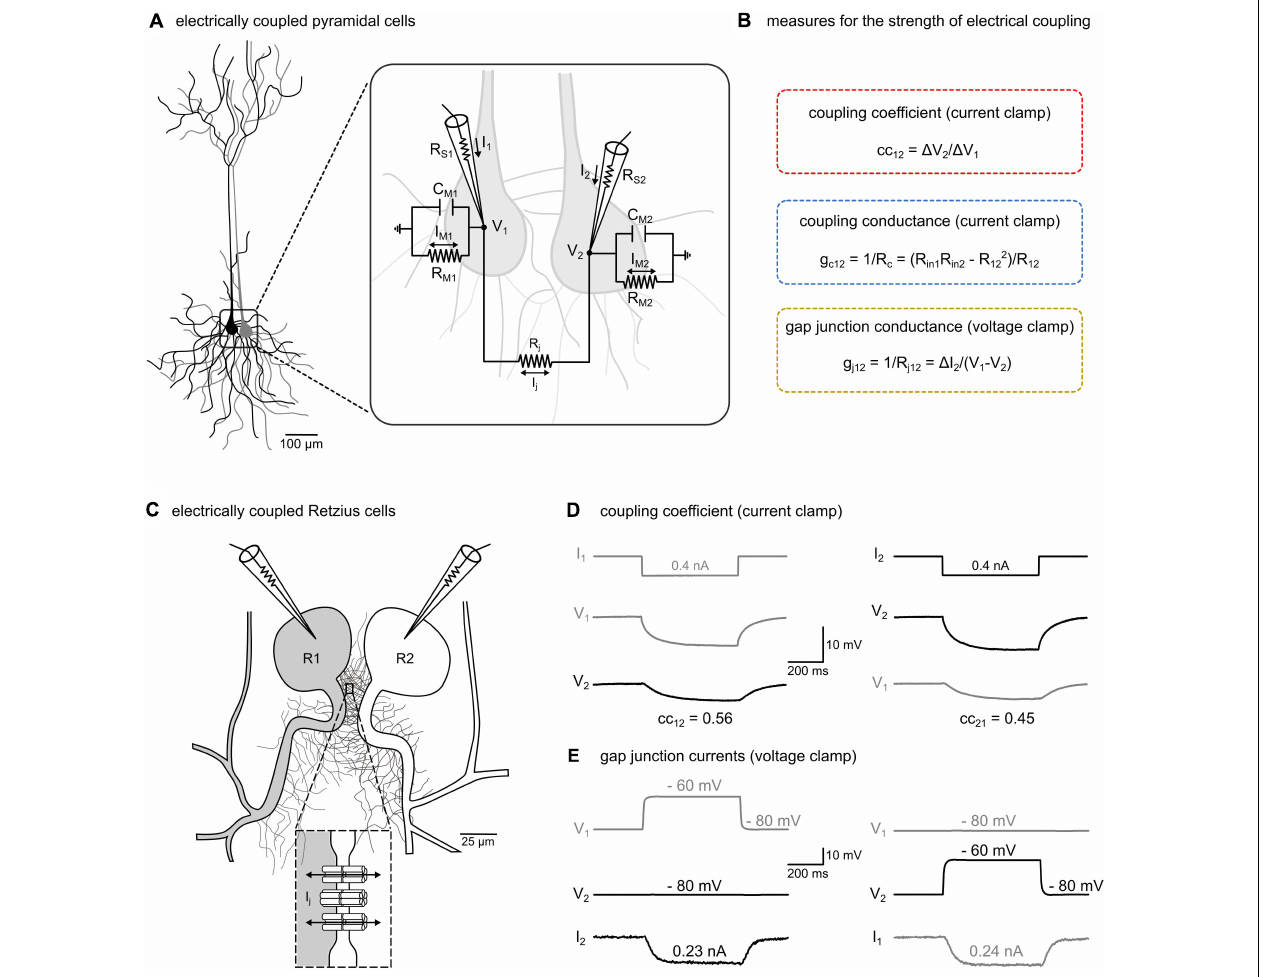
FIGURE 1 | The strength of electrical transmission between electrically coupled neurons can be characterized in current-clamp and voltage-clamp mode. (A) Schematic representation of two typical central mammalian neurons (pyramidal cells) that are electrically coupled. The inset illustrates the equivalent circuit of the electrically coupled cells with recording microelectrodes. R S1 , R S2 : series resistances of microelectrodes. V 1 , V 2 : membrane potentials of the two cells. Cell membranes with resistances R M1 , R M2 and capacitances C M1 , C M2 . R j : gap junctional resistance. I j : gap junctional current. I 1 , I 2 : currents sent through microelectrodes. I M1 , I M2 : currents across membrane resistances. (B) In central mammalian neurons, the strength of electrical transmission is typically inferred from indirect measures such as the coupling coefficient (cc) and the coupling conductance (g c ) but not by directly measuring the gap junctional currents (I j ) and conductance (g j ). For details see section “Materials and Methods,” and (D,E) . (C) Schematic representation of the somata and the neurites emerging from the primary axons of a pair of Retzius neurons (R1 and R2) in the leech nervous system (adapted from Welzel and Schuster, 2018, with permission). The somata are electrically coupled by non-rectifying electrical synapses (see inset) between pairs of neurites within the neuropilar arborizations proximal to the soma (García-Pérez et al., 2004). (D) The coupled R cells allow the measurement and the direct comparison of all three methods. The cc was determined in each direction